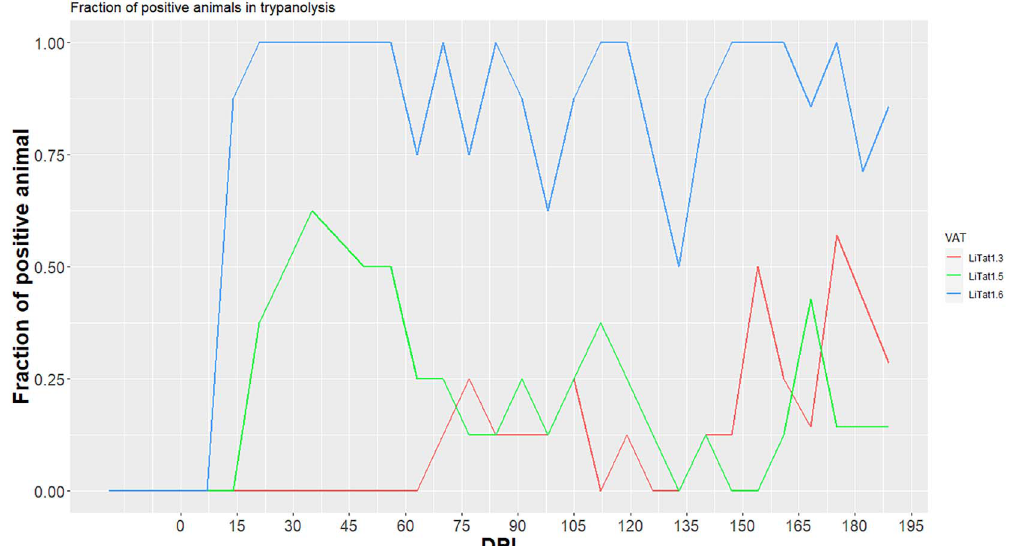
Figure 3. Frequencies of trypanolysis test (TL) positive results in infected pigs during the experiment. Lines indicate the fraction of TL positive pigs (red for LiTat 1.3, green for LiTat 1.5, blue for LiTat 1.6); dpi: days post infection; VAT: variant antigen